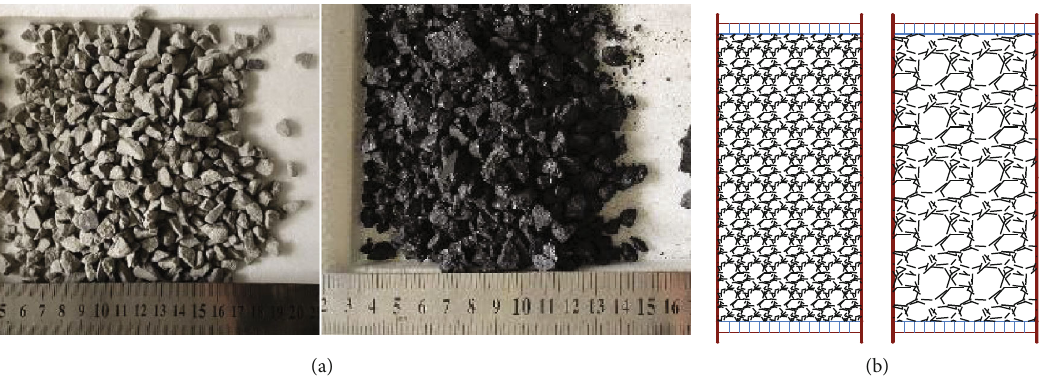
Figure 3: (a) Broken coal and rock and (b) coal